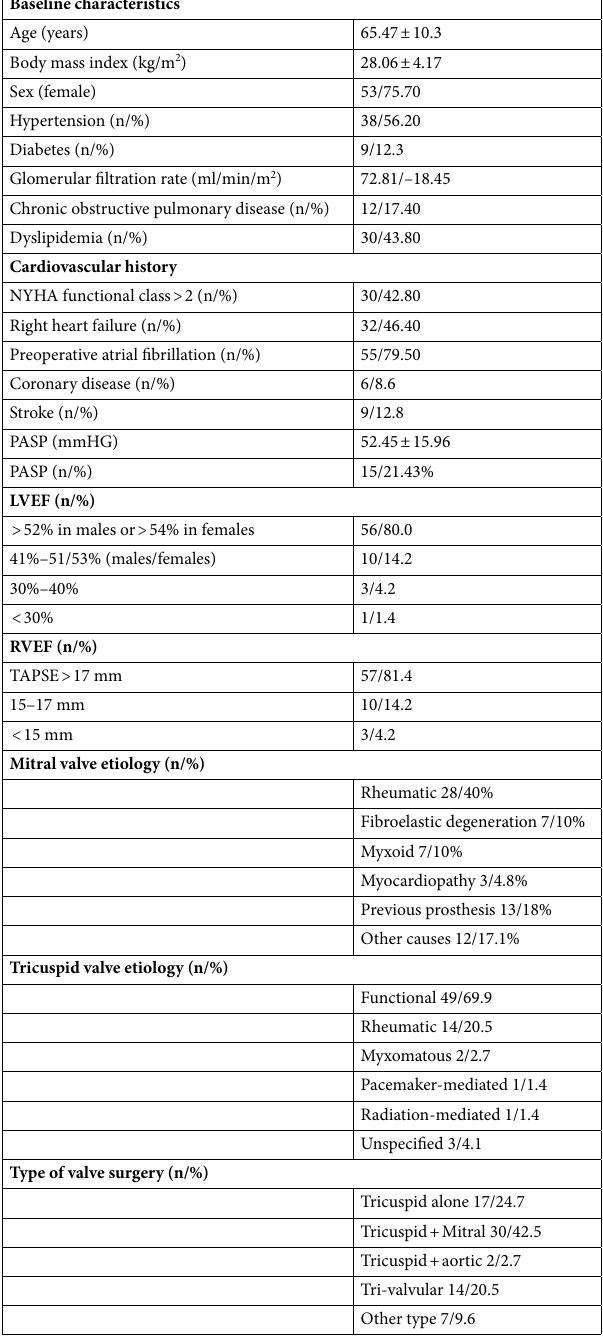
Table 1. Baseline characteristics. NYHA: New York Heart Association; PASP: pulmonary artery systolic pressure; LVEF: left ventricle ejection fraction; RVEF: right ventricle ejection